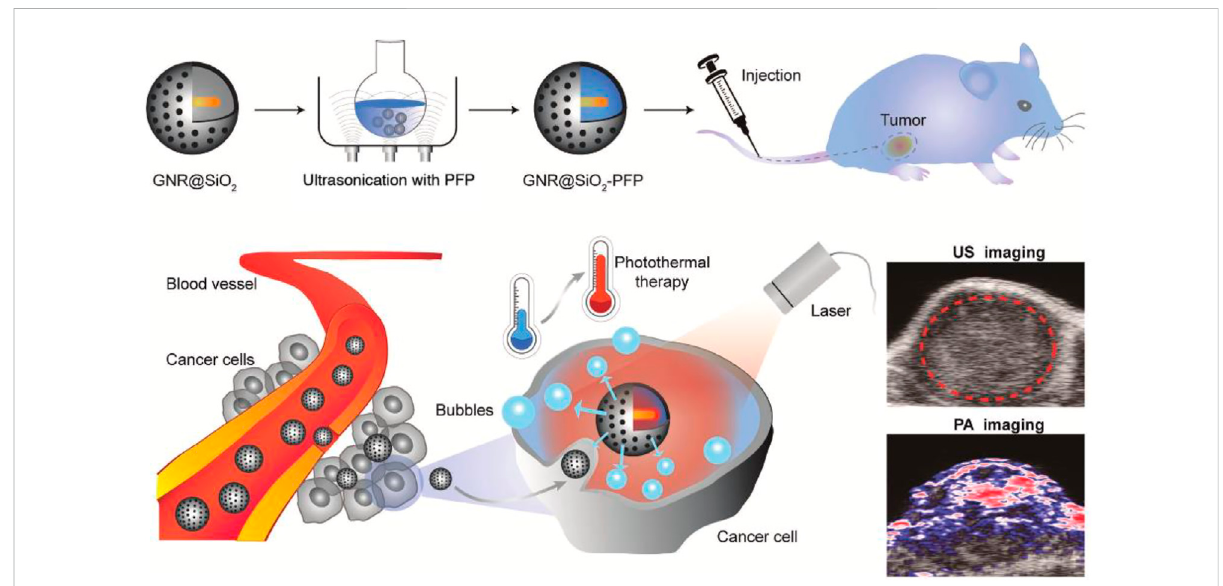
FIGURE 6 Schematic illustration of GNRS@MSN fi lled with PFP from synthesis, in vivo injection, cell entrance, PTT, and dual-mode imaging (US and PA). Reprinted with permission from Wiley (Li C. et al.,